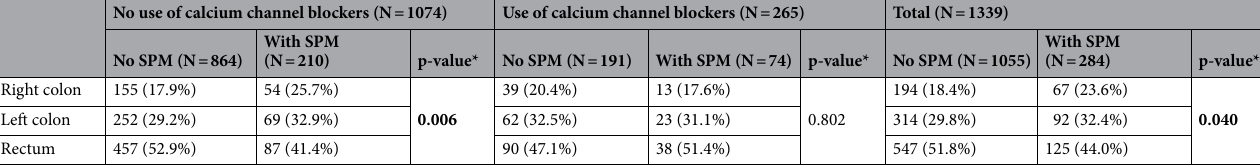
Table 2. The relationship between second primary malignancies and laterality of colorectal cancer stratified by the use of calcium channel blockers excluding patients with C18.4 (transverse colon). SPM second primary malignancy. *Statistical significance for the colorectal cancer site distribution was evaluated using Fisher exact test. Significant values are bold.